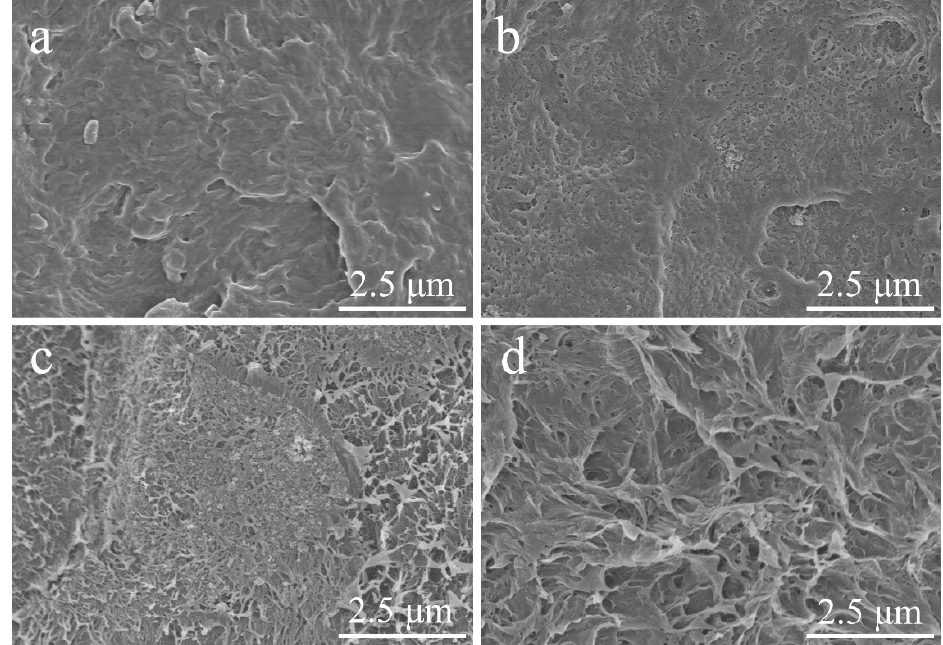
Figure 5. SEM images of ( a ) pure HDPE and its composites brittle fracture surface: ( b ) 1.5ARHA/PE, ( c ) 1.5SiO 2 /PE, and ( d ) 1.5WRHA/PE.